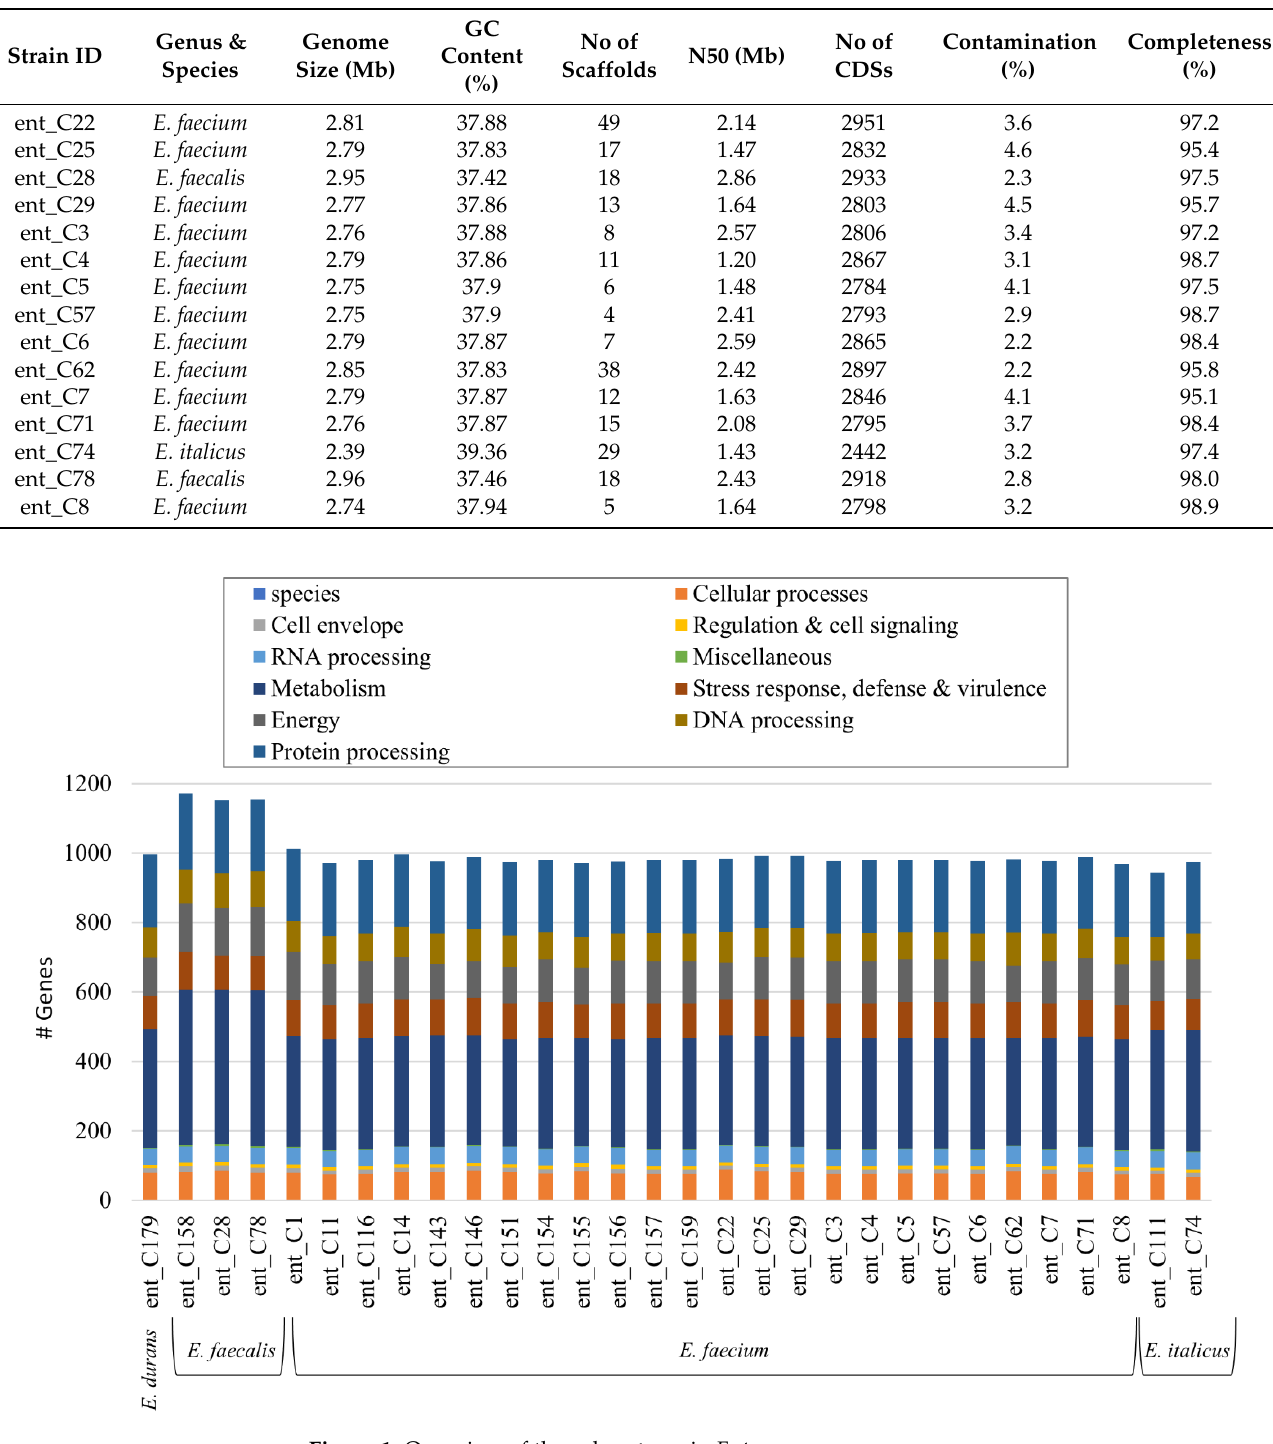
Figure 1. Overview of the subsystems in Enterococcus spp. genomes. Table 1. Species identification and assembly statistics of the 30 Enterococcus spp. isolates.